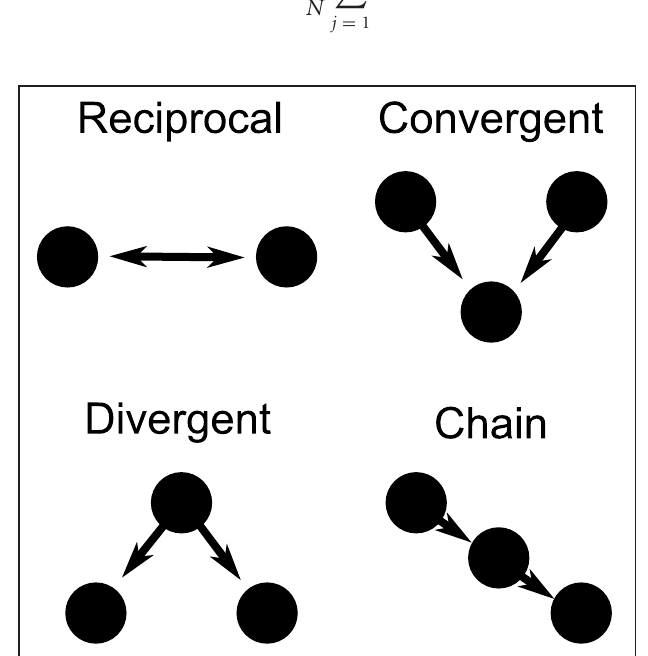
FIGURE 1 | Second order motifs. Connection motifs of two and three-cell combinations with two directional connections. The motifs are reciprocal, convergent, divergent, and chain motifs. The prevalence of these motifs within a larger network can be specified when generating the